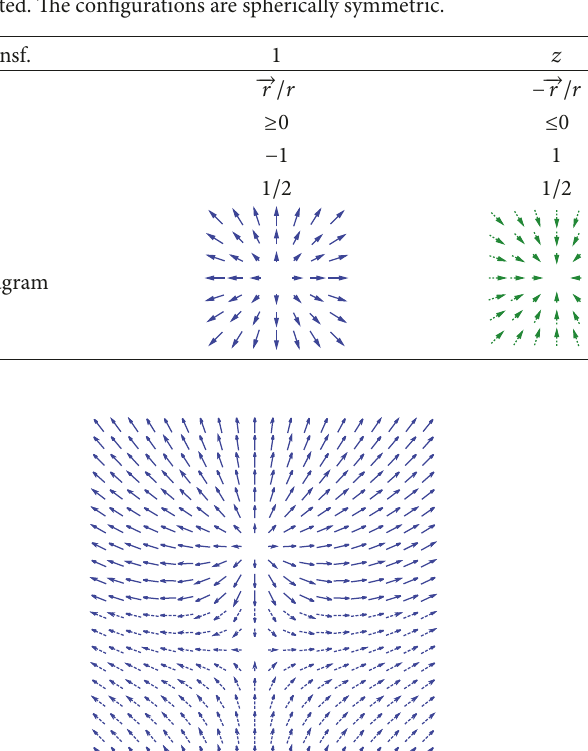
󳨀→ 𝑛 and 𝑞 0 and the topological quantum numbers